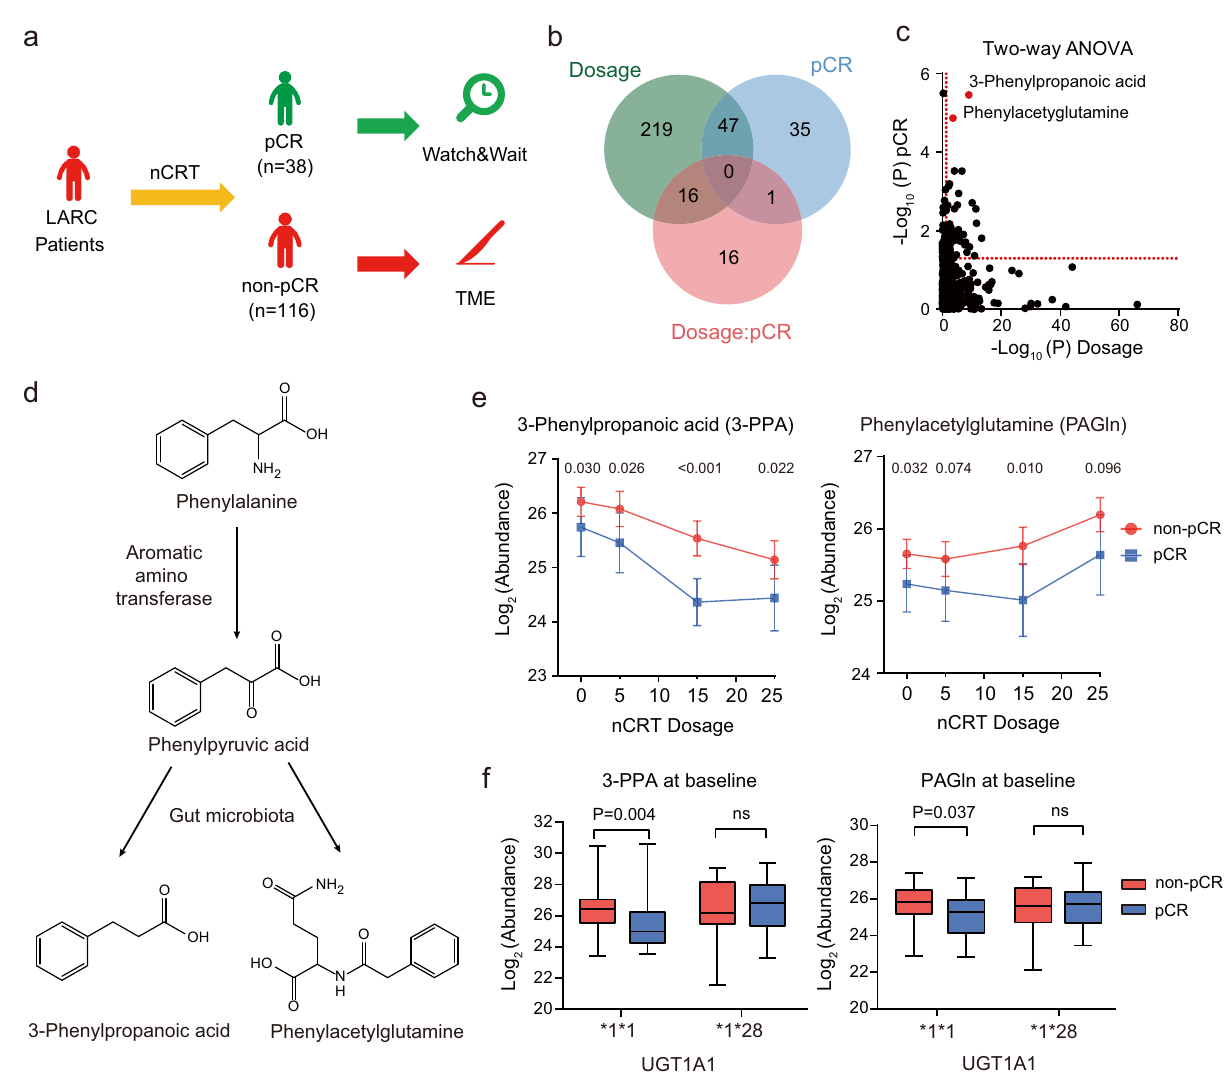
Fig. 4 | Phenylalanine metabolism underlies distinct therapeutic responses of nCRT. a Different therapeutic strategies for pCR and non-pCR patients. b Differentiallychanged metabolitesrelatedtonCRTdosage, pCRstatus, and both combined using the two-way ANOVA analysis ( P <0.05). c 3-Phenylpropanoic acid and phenylacetylglutamine are the most signi fi cant metabolites related to nCRT dosage and pCR status. The red dash line represents the cut-off of P value 0.05 (Two-way ANOVA test). d The scheme for the metabolic pathway of 3-phenylpropanoic acid and phenylacetylglutamine. e Relative abundances of 3-phenylpropanoic acid and phenylacetylglutamine in response to nCRT dosage